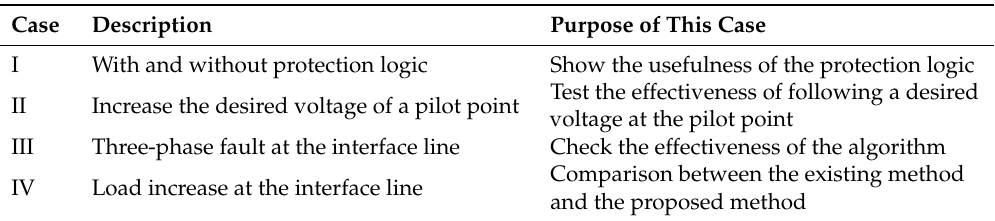
Table 4. Case summary for